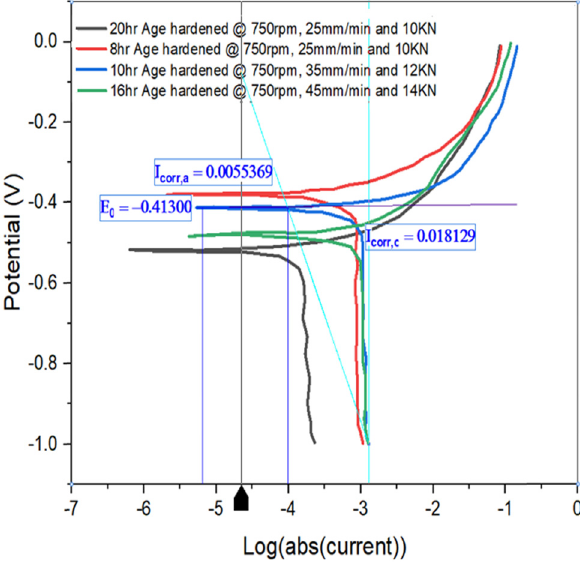
Figure 10: Tafel plot for AH 1 , AH 2 , AH 3 , and AH 4